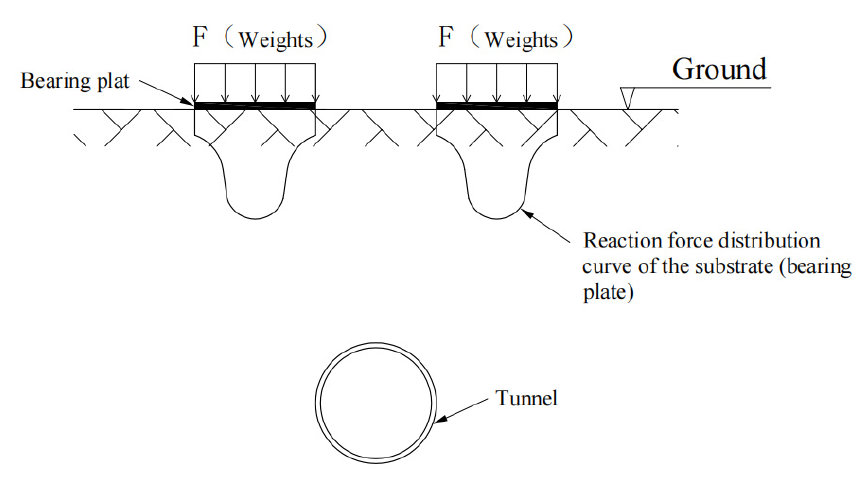
Figure 25. The base (the bottom of the pressure plate) of the reaction force distribution diagram.